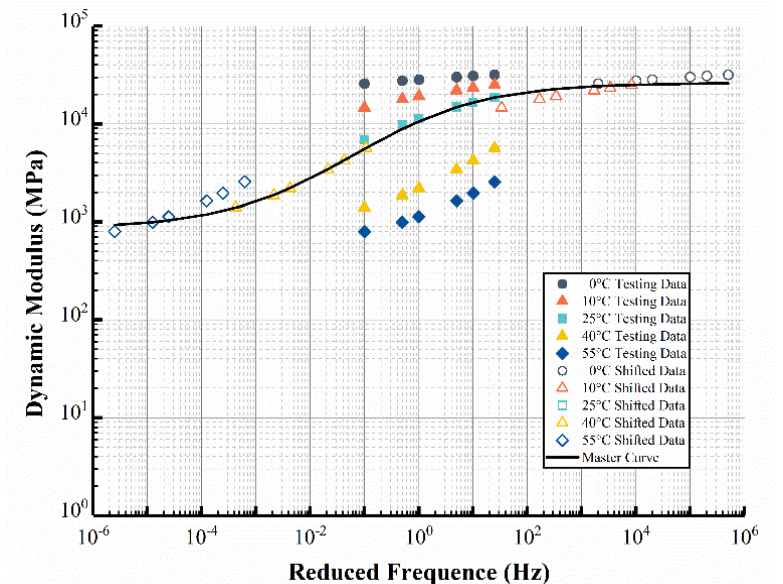
Figure 1. The dynamic modulus master curve of EAC-13.